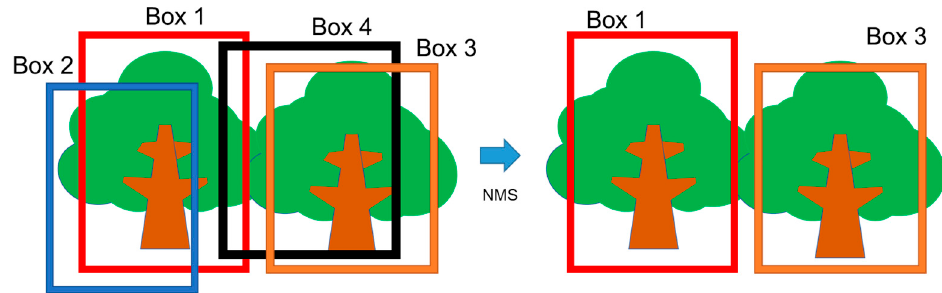
Figure 2. Non-maximal suppression (NMS) for eliminating redundant bounding boxes. The two boxes with intersection over union (IoU) greater than 0.5 were focused upon. One box with a higher score remains, and the other was reduced.